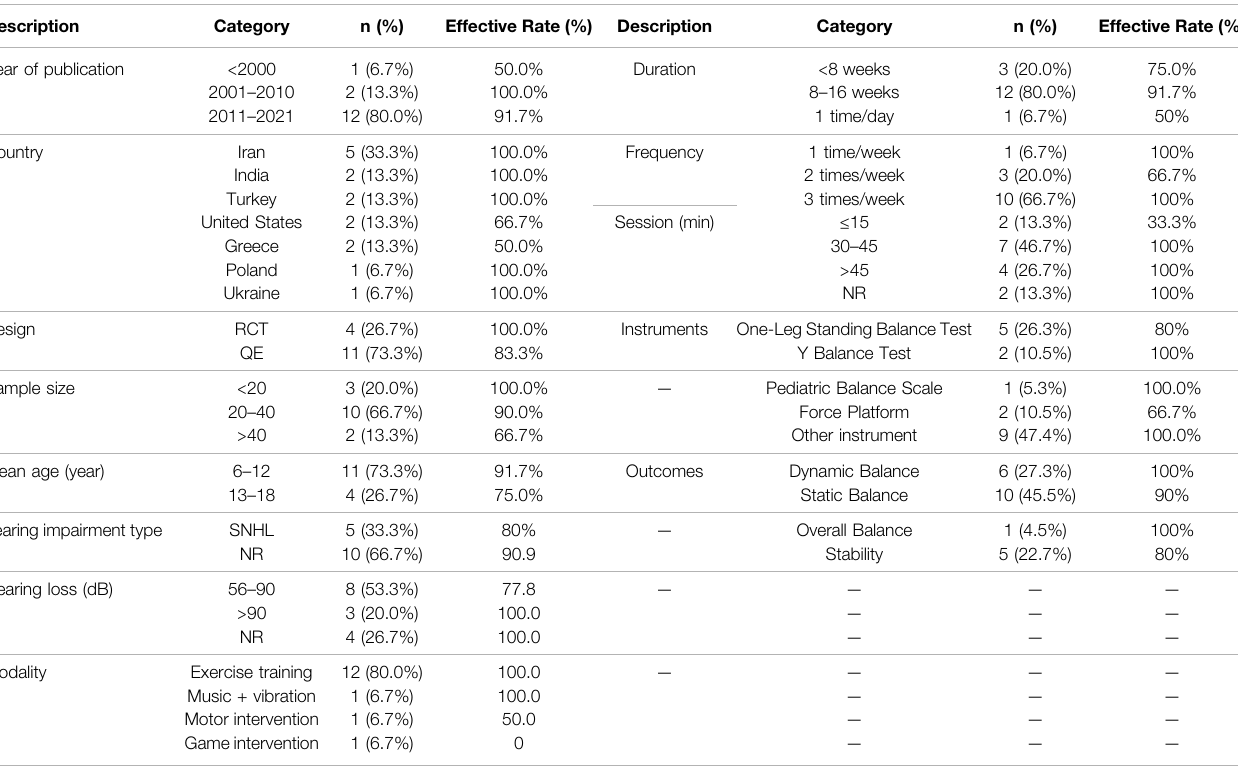
Motor intervention 1 (6.7%) 50.0 — — Game intervention 1 (6.7%)